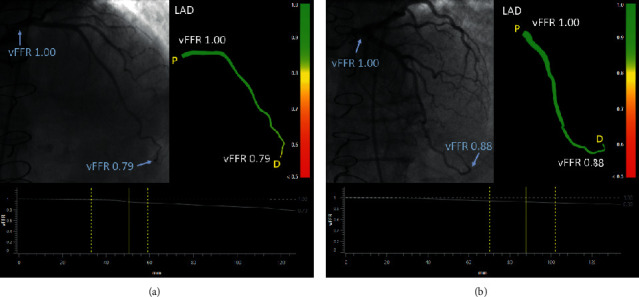
(a) Normal coronary angiogram with functionally significant CAV according to the vFFR analysis. The LAD shows no stenosis on angiography; however, the vFFR shows diffuse pressure losses, and the distal vFFR value is 0.79. (b) Normal angiogram without functionally significant CAV according to the vFFR analysis. The LAD shows no stenosis on angiography, and the vFFR shows small pressure losses resulting in a distal FFR value of 0.88. CAV, cardiac allograft vasculopathy; LAD, left anterior descending coronary artery; and vFFR, vessel fractional flow reserve.